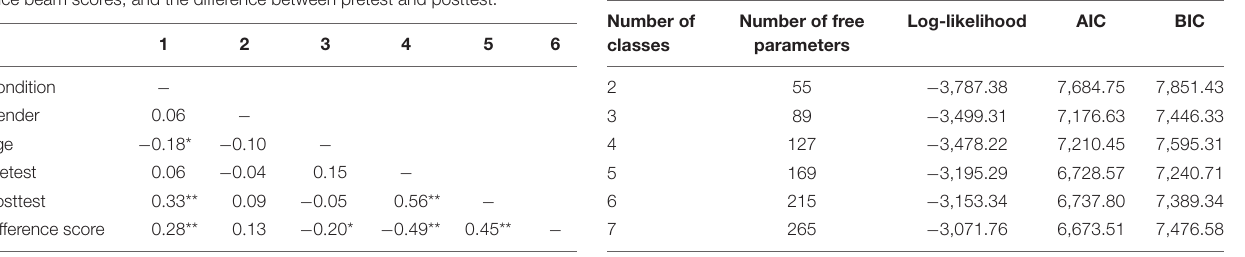
TABLE 3 | Fit of the models with two to seven